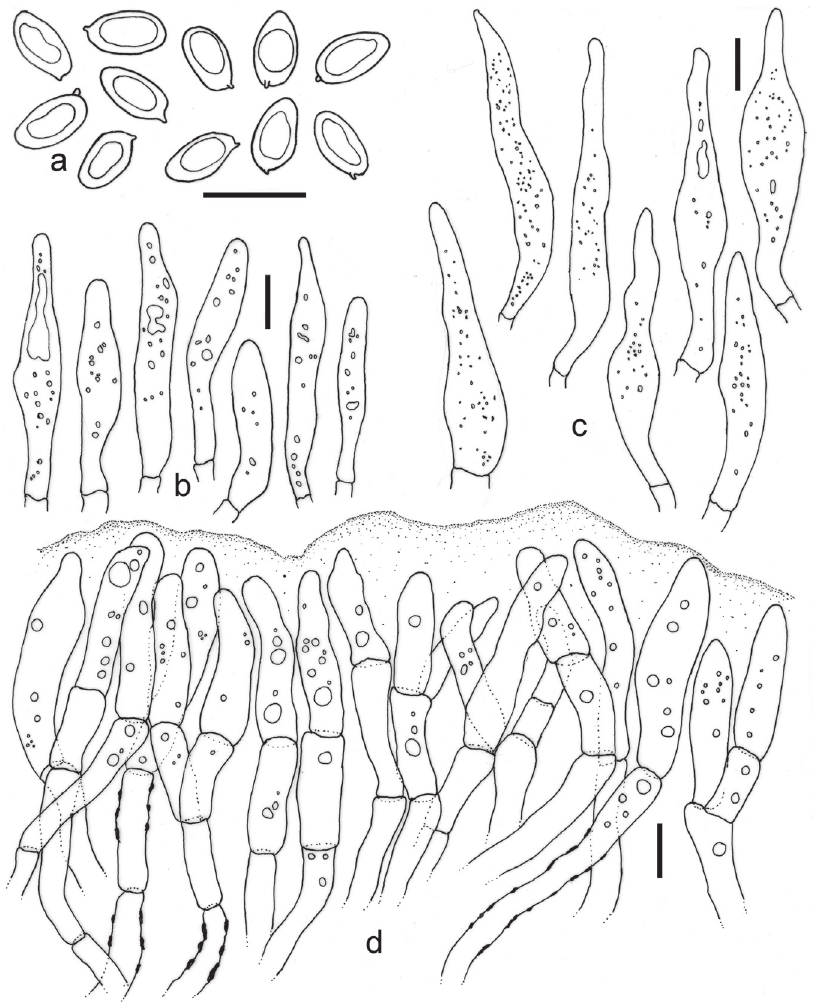
Figure 8. Tylopilus neofelleus (DC 16-63). a Basidiospores b Pleurocystidia c Caulocystidia d Pileipellis. Scale bars: 10 µm ( a–d